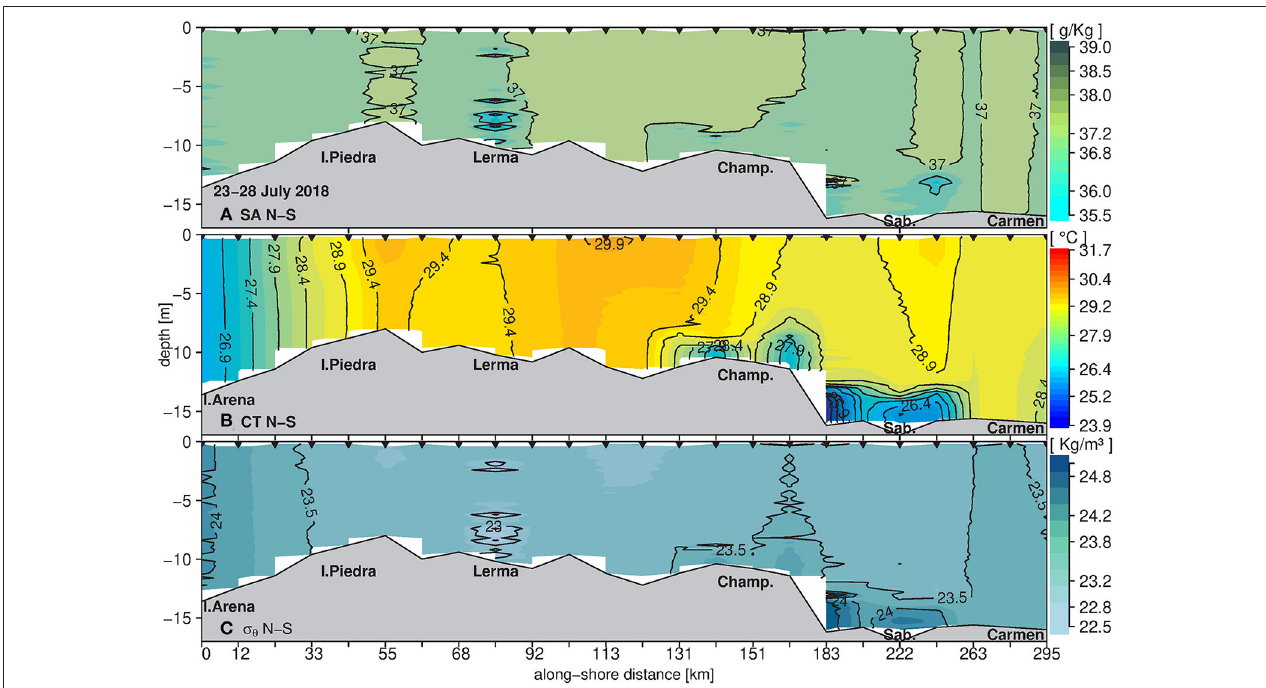
FIGURE 6 | Along-shore view of the vertical distribution of (A) absolute salinity (g/kg), (B) conservative temperature ( ◦ C), and (C) density ( σ θ in kg/m3), for the sampling stations aligned from north to south (L2 on Figure 1 ). Black triangles on top depict sampling stations. This figure synthesizes 6 days of observations, from July 23 to July 28, 2018.